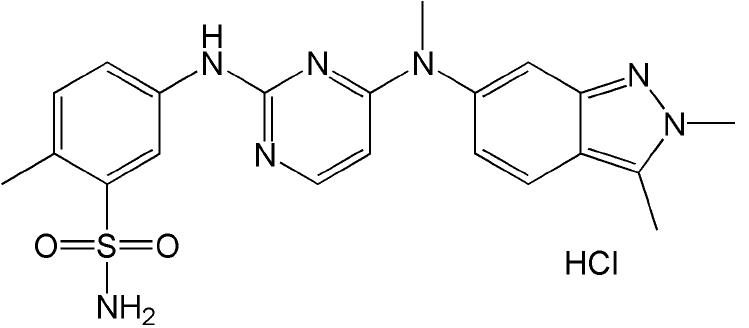
Figure 1. Structure of pazopanib hydrochloride.